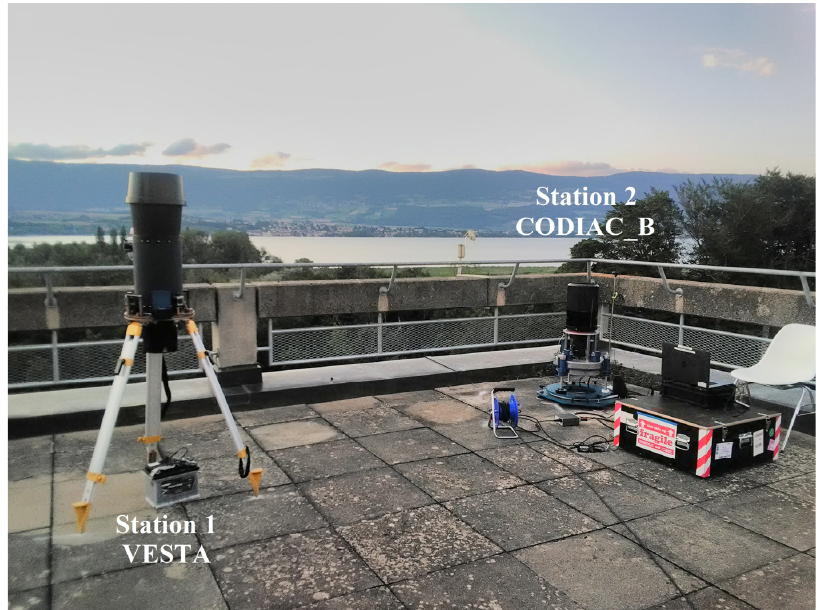
Figure 3. Comparative measurements of VESTA and CODIAC Blue (CODIAC_B) at HEIG-VD.